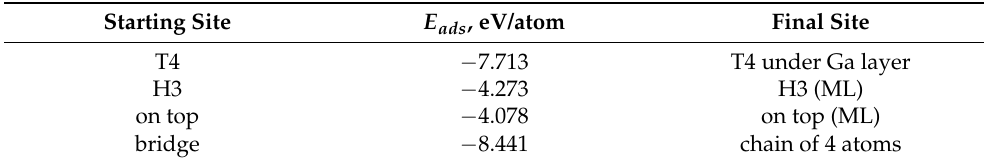
Table 1. Adsorption energies for C adsorbates on the GaN ( 0001 ) surface. Coverage 1 ML, 2 × 2 lateral